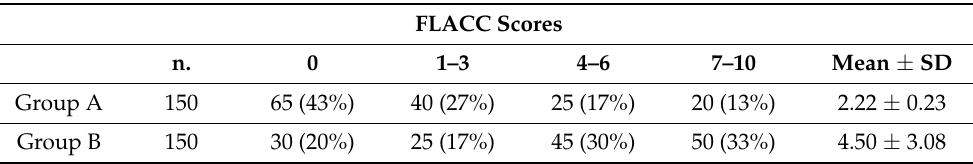
Table 2. Distribution of the FLACC scale pain ratings.